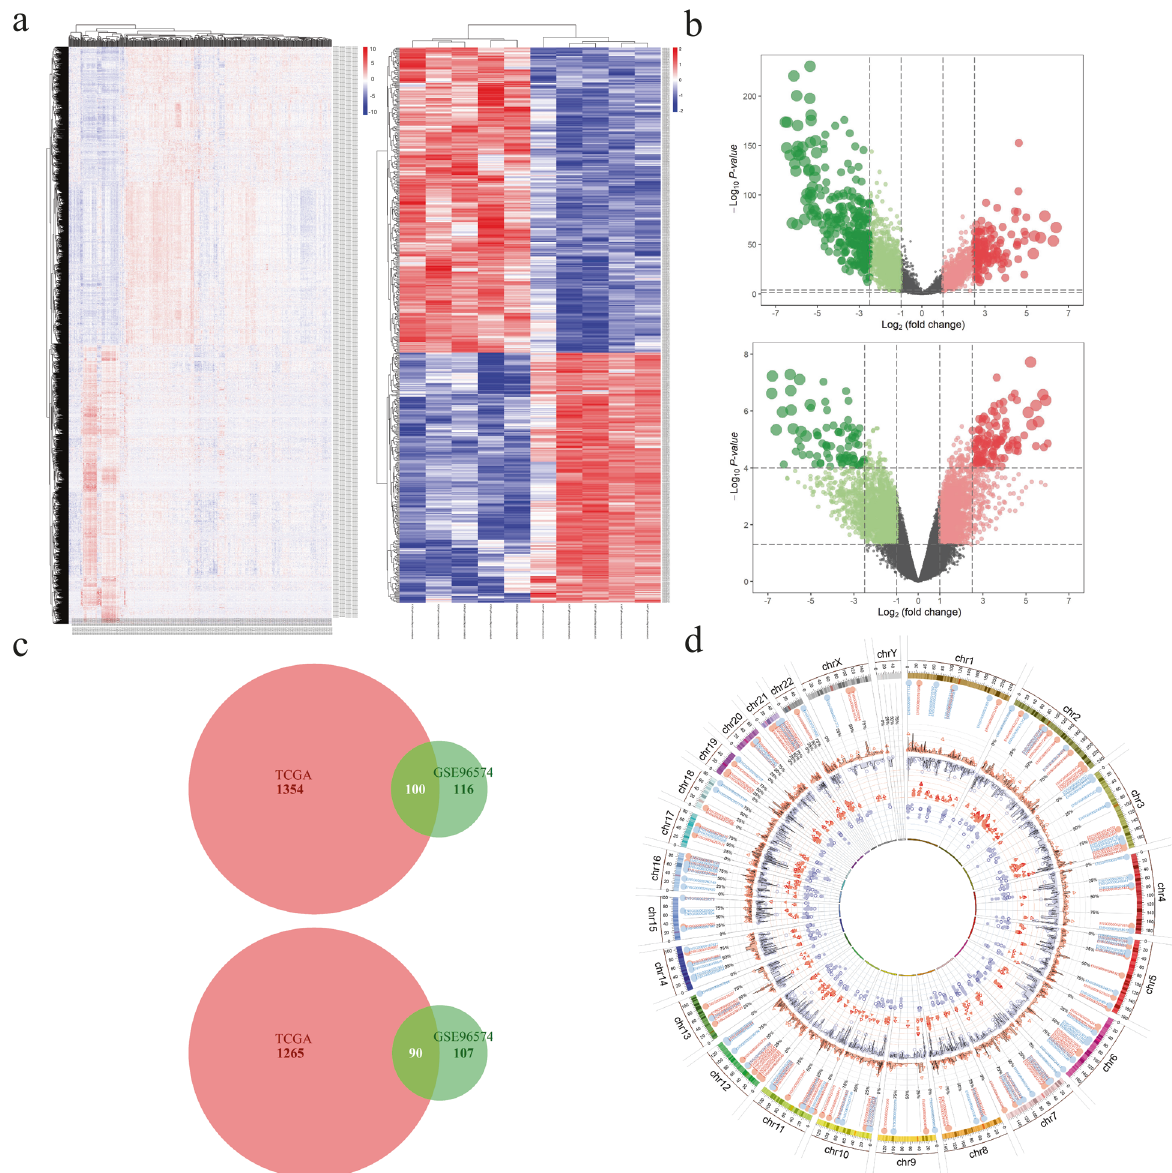
Fig. 1 Identi fi cation of differentially expressed lncRNAs. a , b Hierarchical clustering heatmap ( a ) and volcano plots ( b ) of TCGA and GSE96574 showing the differentially expressed lncRNAs between ccRCC samples and normal samples. c Comparison of the differentially upregulated or downregulated lncRNAs in the two datasets. d A Circos plot was used to show the differentially expressed lncRNAs (log 2 fold change (FC) | > 1, P < 0.05). The inner circle shows the downregulated lncRNAs (purple dots) and the second circle identi fi es the upregulated lncRNAs in ccRCC tissues (red triangles) according to GSE96574. The third circle shows the downregulated lncRNAs (purple dots) and the fourth circle identi fi es the upregulated lncRNAs in ccRCC tissues (red triangles) according to TCGA. The outside circle represents the overlap of upregulated (pink dot) or downregulated lncRNAs (blue dots). biomarker for prognosis prediction and treatment for ccRCC patients. RESULTS Identi fi cation of differentially expressed lncRNAs in ccRCC and normal tissues Based on integrated analysis of the lncRNA-expression pro fi les obtained from TCGA and GEO datasets, we identi fi ed 2809 (1454 upregulated and 1355 downregulated lncRNAs) and 413 (216 upregulated and 197 downregulated lncRNAs) differentially expressed lncRNAs (DElncRNAs), respectively (Fig. 1a, b). After